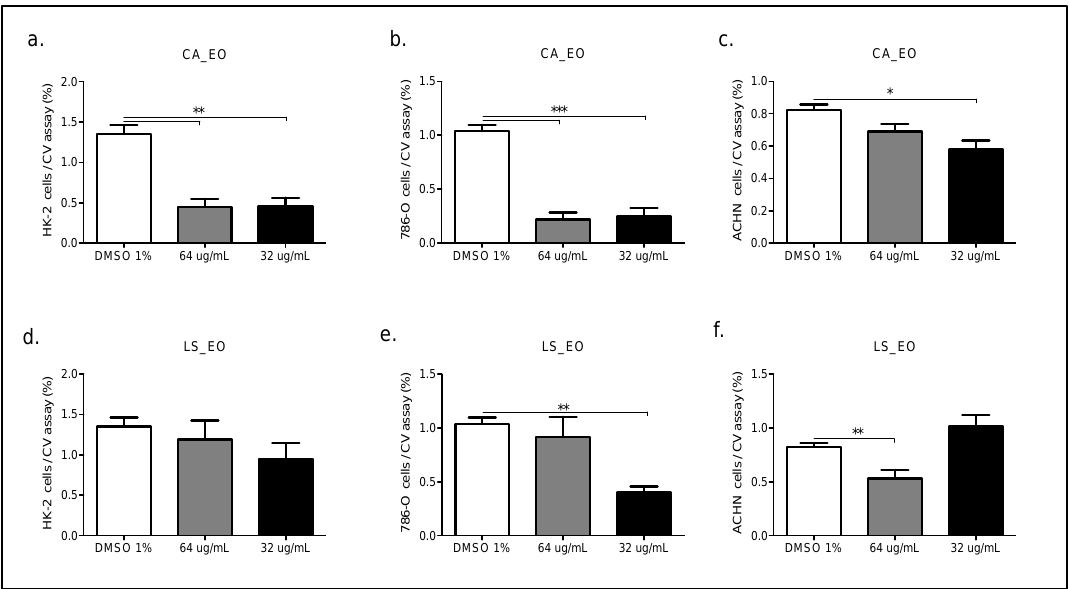
Figure 2. Dose-response curve of the human epithelial mammary tumor cell line MCF-7 ( a , b ) and epithelial mammary non-tumoral cell line MCF10A( c , d ) treated with CA or LS EOs. The graph bar corresponds to the proliferation of MCF-7 treated with the EOs at different concentrations versus control (DMSO 1%) for 48 h, evaluated by CV assay at 570 nm. Three independent trials were performed, in triplicate, for each treatment and concentration. *** p < 0.001.